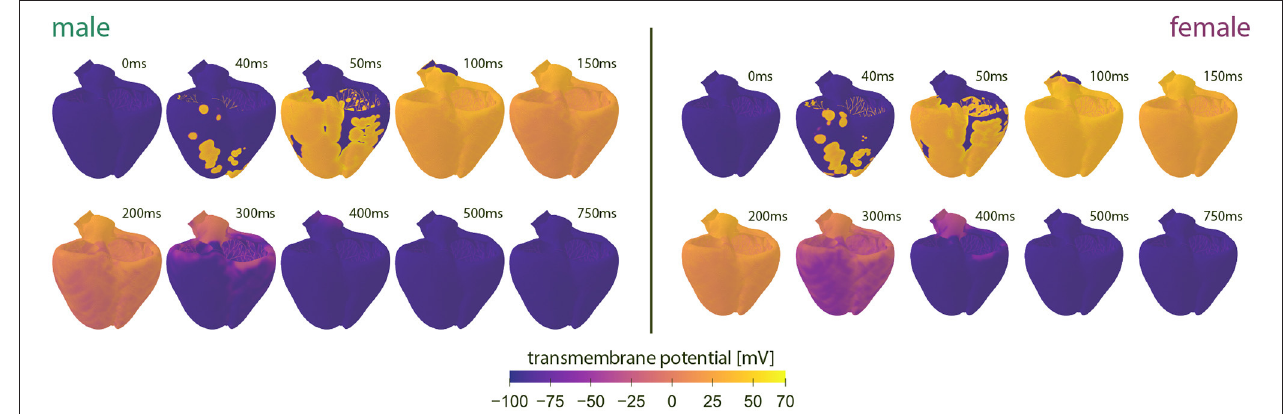
FIGURE 4 | Baseline spatiotemporal excitation profiles for the male and female heart . Evolution of the transmembrane potential for the male and female heart without drugs. Snapshots are taken from the last simulated beat. During depolarization, the Purkinje fibers drive the sharp depolarization front from apex to base. During repolarization, both ventricles gradually return to their resting state. The combined sex-differences in ion channel activity, tissue conductivity and organ-scale geometry lead to a slower depolarization in the female heart than the male heart.